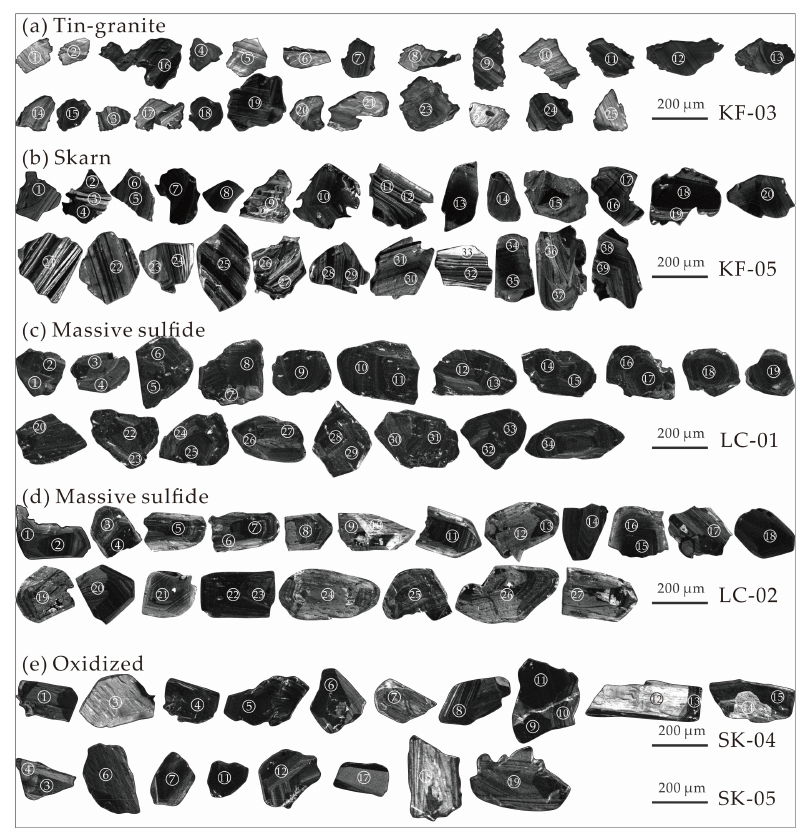
Figure 4. Representative cathodoluminescence images of the cassiterite samples from the Gejiu tin polymetallic deposit, showing internal textures of cassiterite grains. ( a , b ) Cassiterite grains from the tin–granite ore style display a regular oscillatory zoning; ( c , d ) Cassiterite grains from the massive sulfide ore style display an inner core with a regrowth rim; ( e ) Cassiterite grains from the oxidized ore style display an inner core and oscillatory